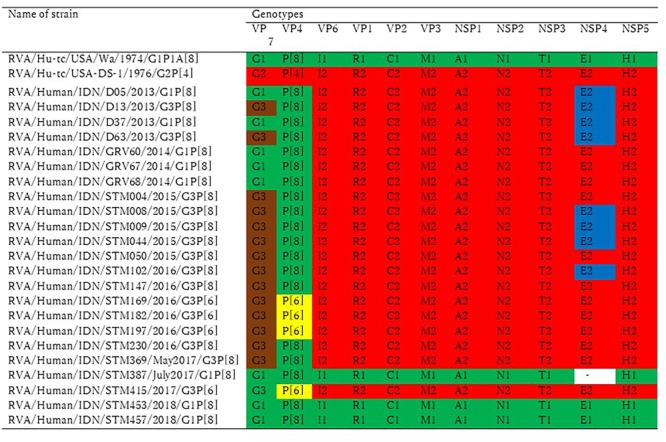
Genotype constellation comparison by the study period. The 23 Indonesian RVA strains in this study were analyzed by whole genome sequences. Green and red indicate Wa-like and DS-1 like gene segments, respectively. The P[6] VP4 genotype is colored yellow, brown is used to indicate a gene segment of equine origin, and blue is used to indicate a gene segment of bovine origin.